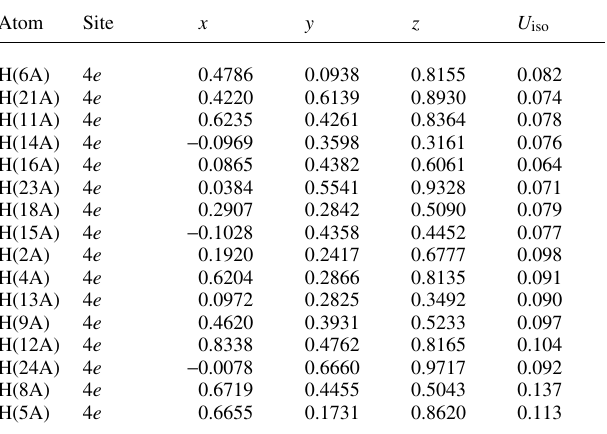
Table 2. Atomic coordinates and displacement parameters (in Å 2 )